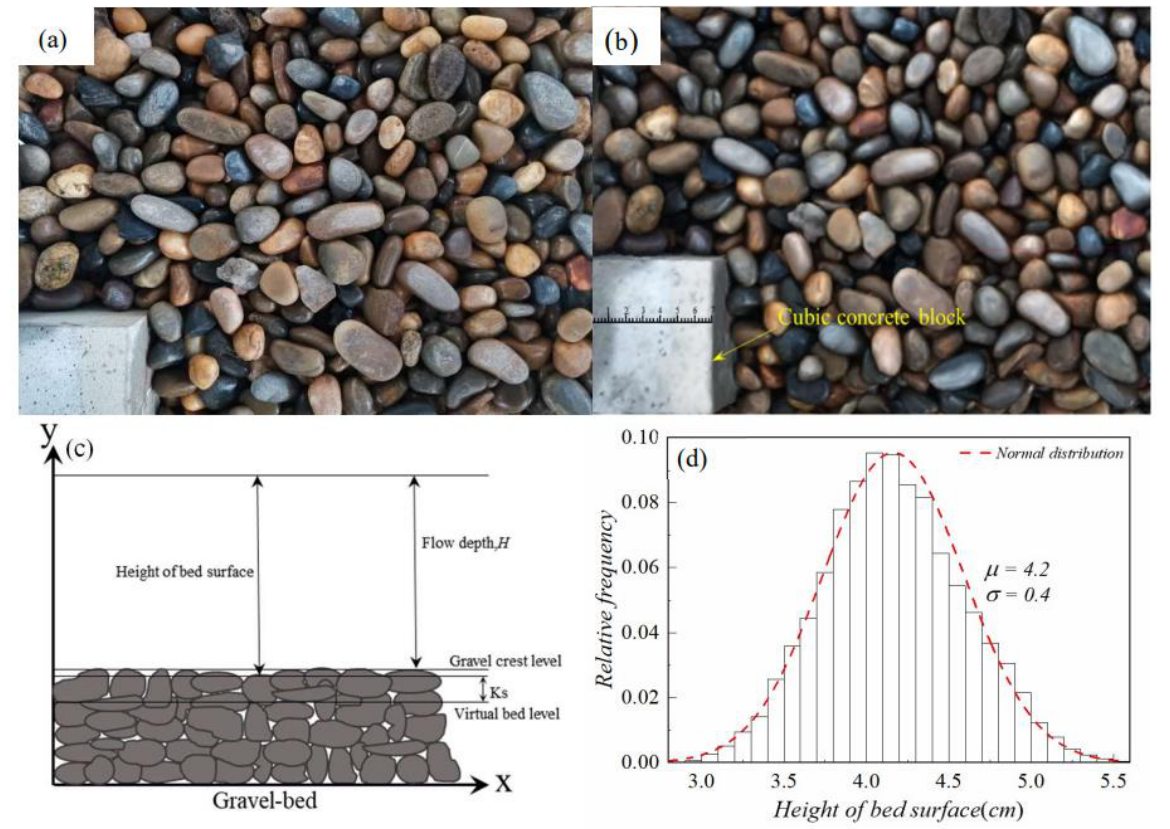
Figure 2. Characteristics of the rough-bed: ( a ) realistic view of the rough-bed surface (18 × 15 cm 2 ); ( b ) rough-bed terrain reconstructed by structure from motion (SFM) technology; ( c ) schematic of the height of the rough-bed surface; ( d ) probability distribution of bed surface height.